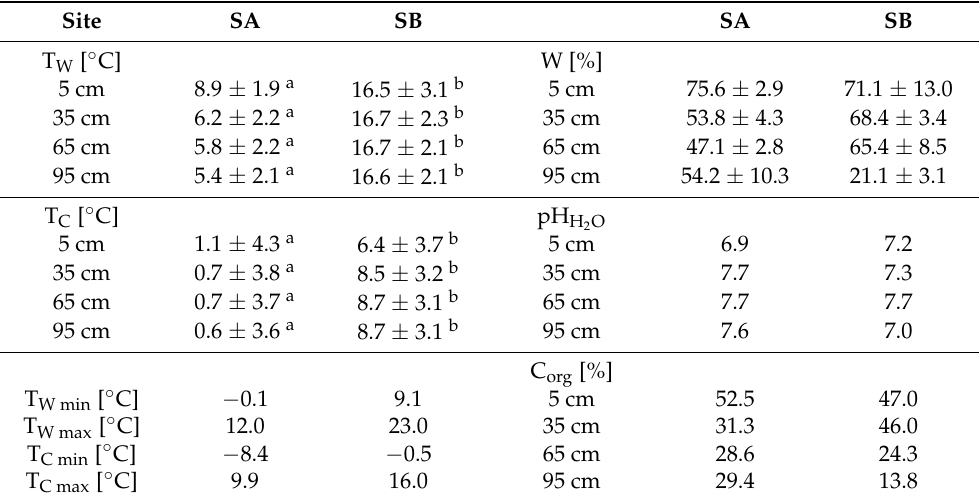
Table 1. Microclimatic and soil-chemical characteristics (mean ± standard deviation) at two scree slope sites in the Z á diel Valley.